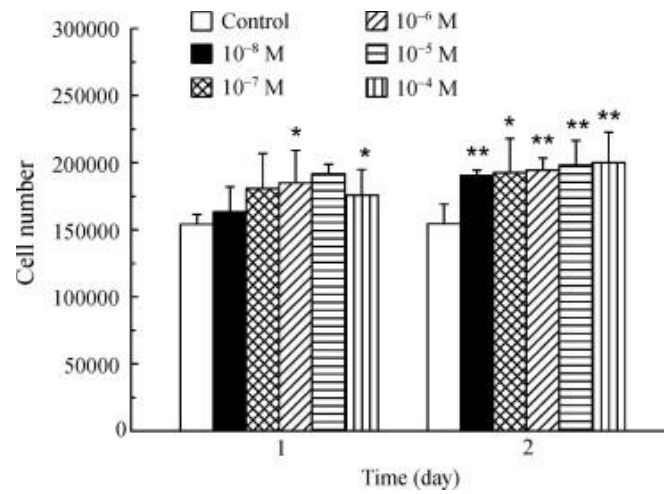
Figure 13. Effect of La 3+ on osteoblasts proliferation [70] . (* p < 0.05; ** p < 0.01)